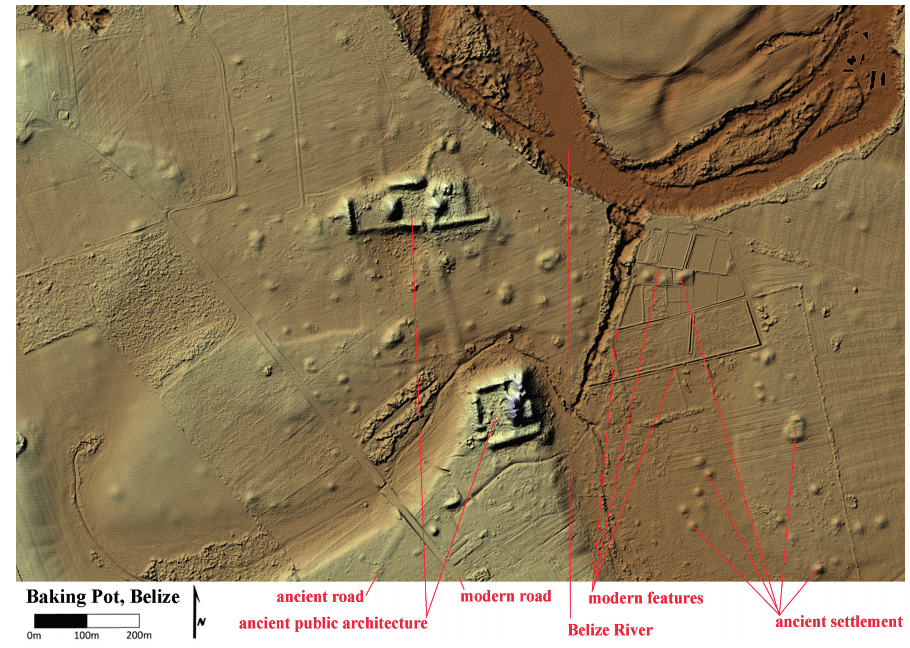
Figure 9. 2.5D LiDAR bare earth rendering of the site of Baking Pot, located on the Belize floodplain (Belize River in upper